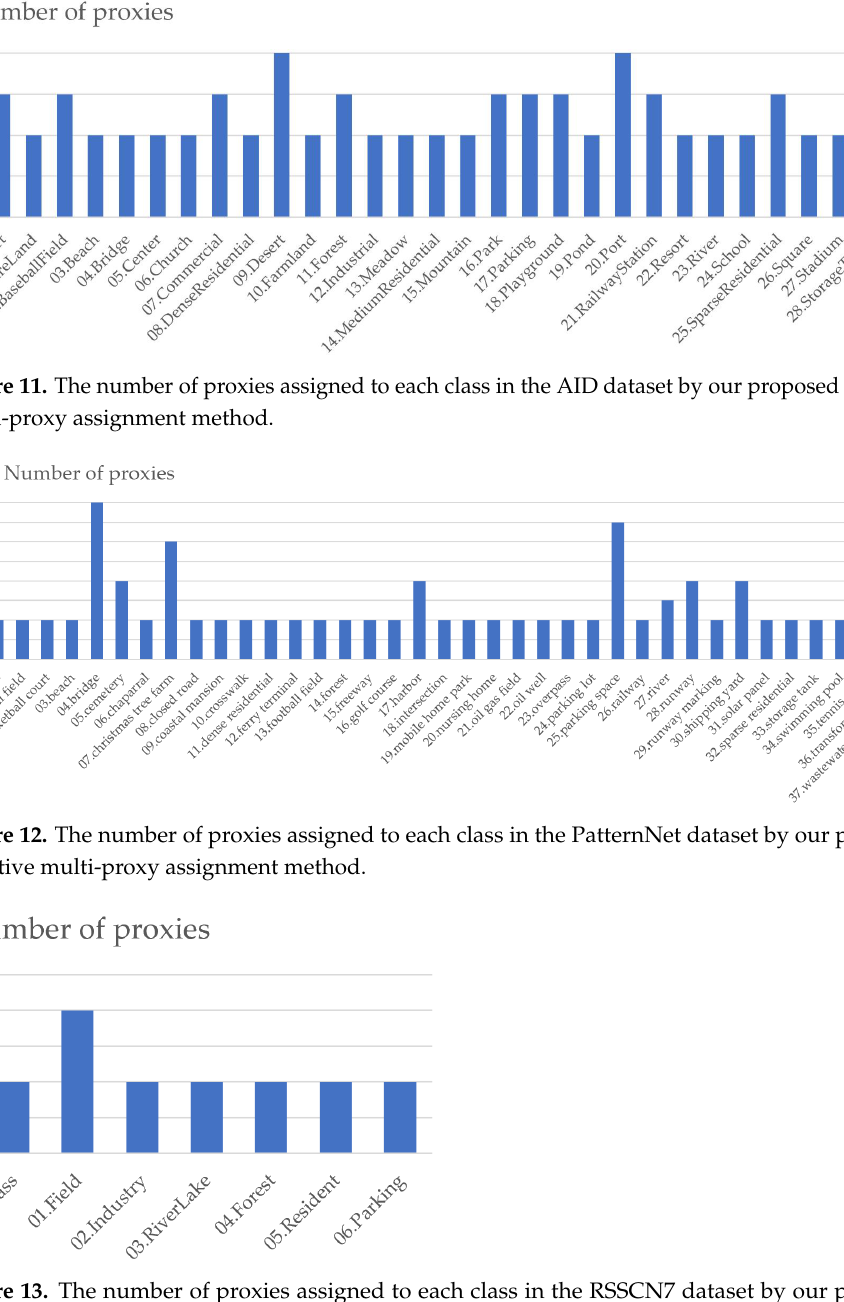
Figure 13. The number of proxies assigned to each class in the RSSCN7 dataset by our proposed adaptive multi-proxy assignment method.